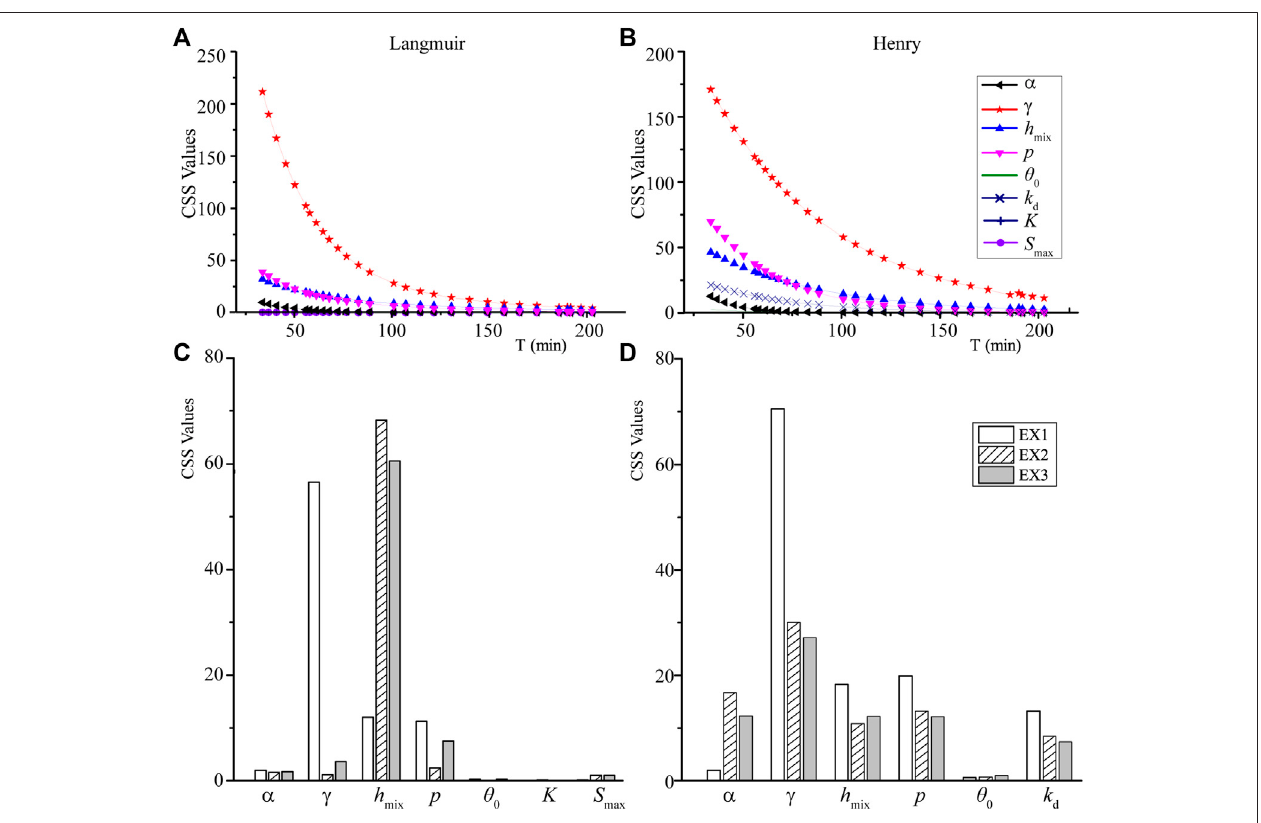
FIGURE 5 | CSS values of Langmuir (A) and Henry (B) models along time during the rainfall-runoff process; (C) and (D) represent the mean values of CSS at different times for each parameter in the model with Langmuir and Henry equations, respectively.